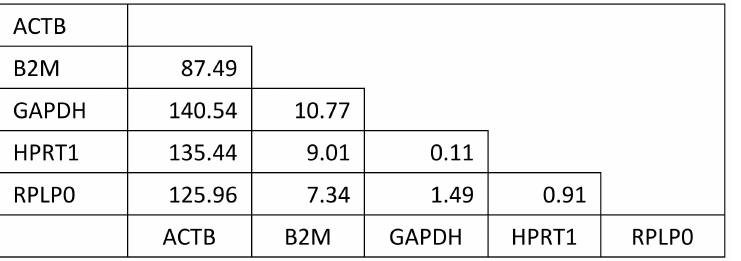
Figure 8. Analysis of variance of difference to determine most suitable housekeeping genes. Candidate housekeeping genes were considered in a pairwise fashion to determine which ones were the most consistently expressed independent of experimental condition within this study. GAPDH and HPRT1 displayed the minimum variance of difference over all experimental conditions and timepoints.